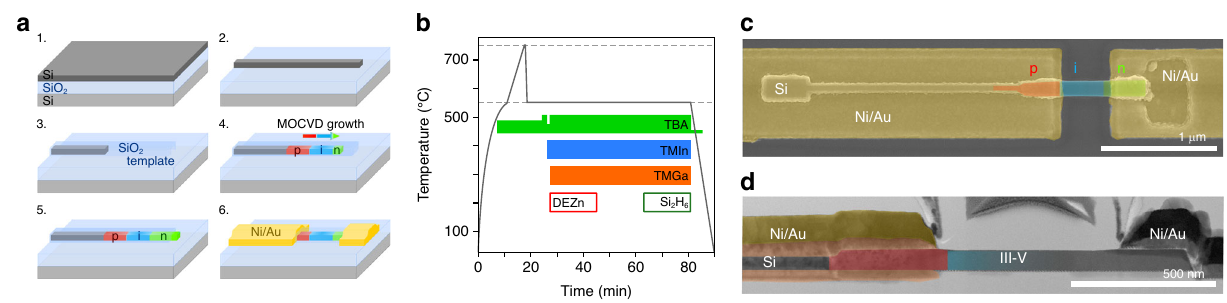
Fig. 2 Template-assisted selective epitaxy fabrication process. a Process steps during TASE. 1. SOI wafer. 2. Patterned top Si layer. 3. Partially hollow SiO 2 template with Si seed. 4. MOCVD growth of p – i – n InGaAs. The arrow indicates the growth direction. 5. p – i – n nanostructure after growth. 6. Ni/Au contacts on nanostructure. b Schematic of the p – i – n InGaAs MOCVD growth sequence. The colored regions correspond to the turning on of the fl ow of precursors. First, an annealing step is performed to desorb water residues. Next, a short InAs seed is deposited for nucleation followed by the p – i – n InGaAs growth. Details can be found in the Supplementary Note 1. c False-colored SEM top view of p – i – n nanostructure. d Bright fi eld STEM image of a cross- section of the nanostructure in ( c ). Colors indicate materials in the left part.